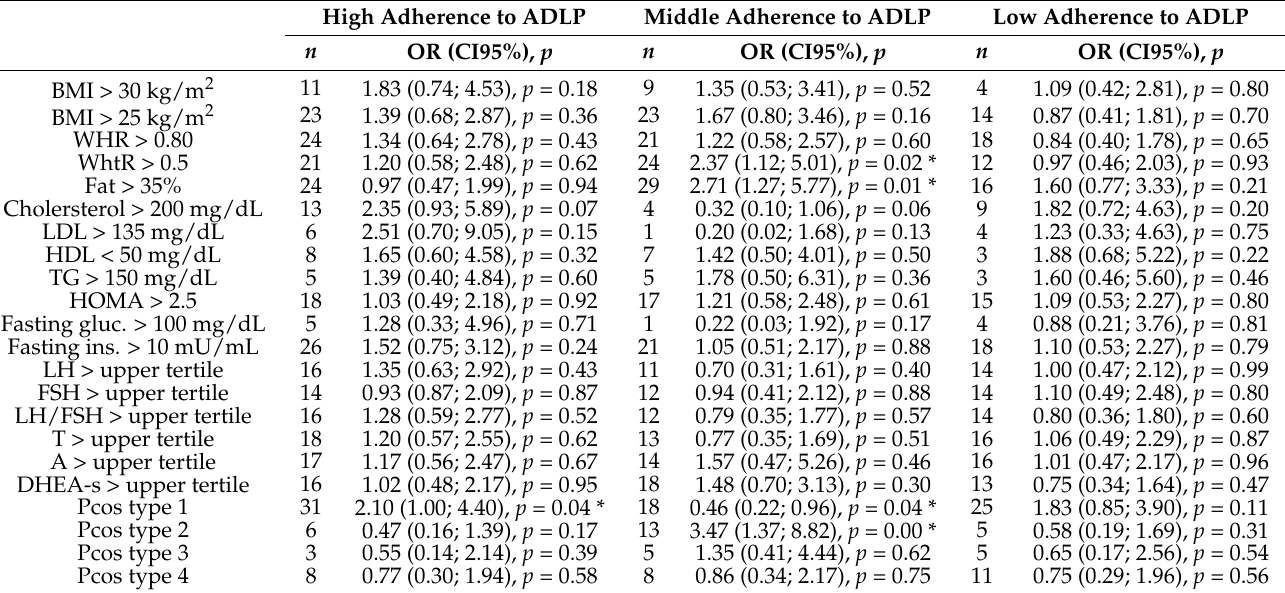
Abbreviations: BMI—Body Mass Index, WHR—Waist-to-Hip Ratio, WHtR—Waist-to-Height Ratio, T. Chol.—total cholesterol; HDL—High-density lipoprotein, LDL—Low-density lipoprotein, TG—Triglycerides, HOMA-IR— Homeostatic Model Assessment—Insulin Resistance, Fasting gluc.—fasting glucose, Fasting ins.—fasting insulin, FSH—Follicle Stimulating Hormone, LH—luteinising hormone, T—total testosterone, A—androstenedione; DHEA-s—Dehydroepiandrosterone sulfate. The p values below the threshold of statistical significance are marked with the * p < 0.05. Table 4. The adherence to the active dietary-lifestyle pattern (DLP) and it’s relation with different metabolic and endocrine